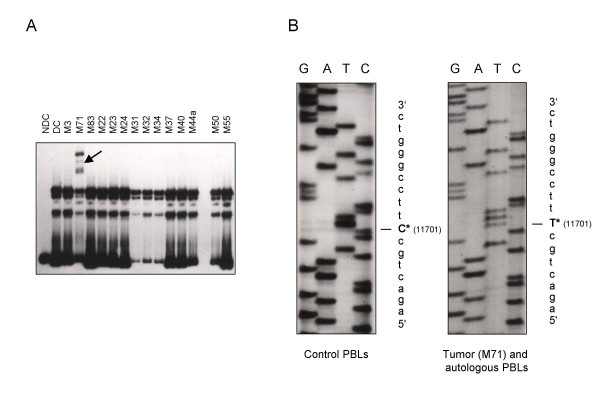
New single nucleotide polymorphism found in intron 1 of the TP53 gene (C>T transition) at position 11701. (A) PCR-SSCP analysis of melanoma tumors. The arrow indicates the shifted band in melanoma tumor M71. DC, denaturing control; NDC, non-denaturing control. (B) DNA sequence of melanoma tumor M71 and autologous PBLs showing the C to T base change (shown by an asterisk *) at position 11701 compared with control PBLs.